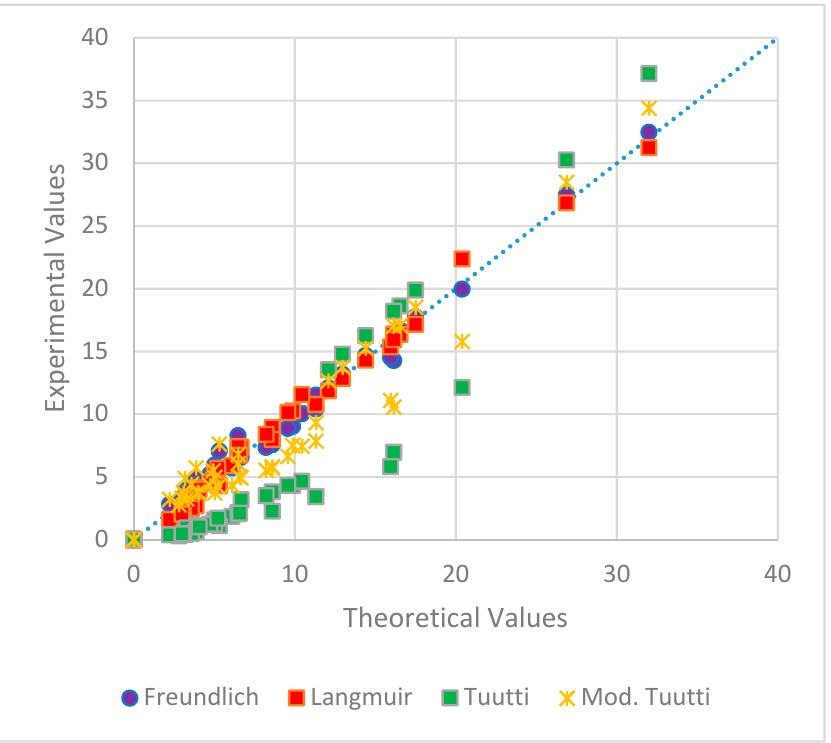
Figure 5. Linear regression analysis of the theoretical versus experimental results. The Freundlich isotherm showed the best fit to the experimental data, followed by the Langmuir model. The worst fit for a model was found for the Tuutti’s model, owing to the linearity of the